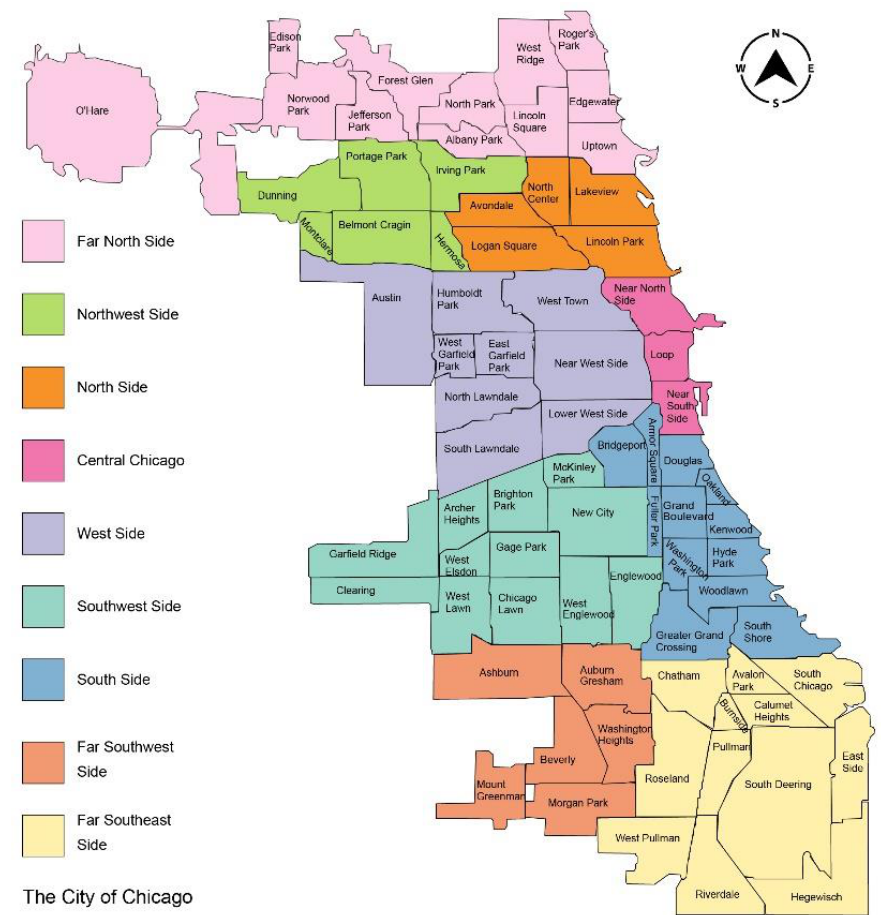
Figure 1. Chicago neighborhood maps. Adapted from Wiki commons.